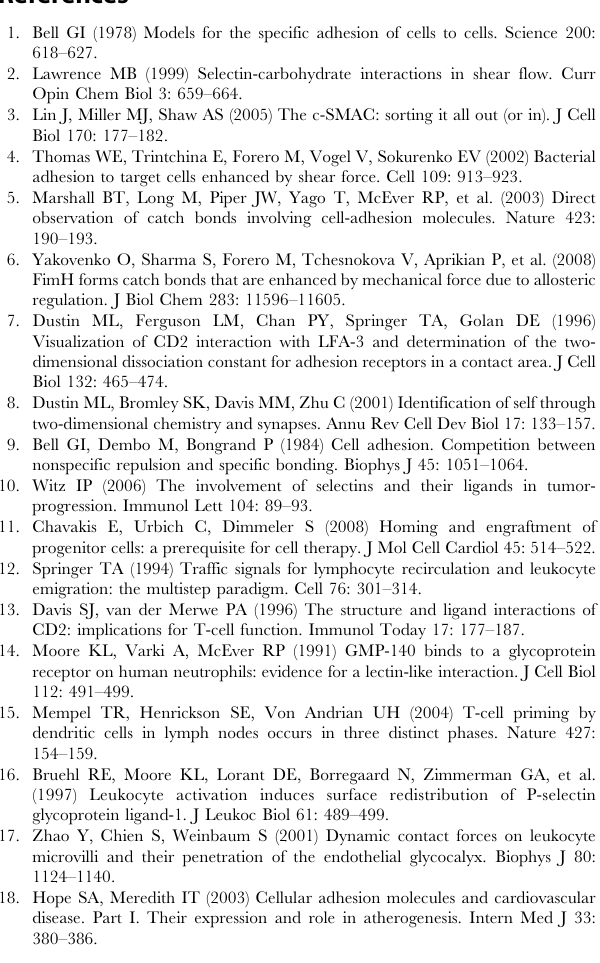
Figure S4 Velocities using the five-parameter catch-slip model dissociation parameters derived from the experiments of Marshall et al. Instantaneous velocity results from simulations utilizing the dissociation kinetics from the study by Marshall et al. are presented as a function of time.